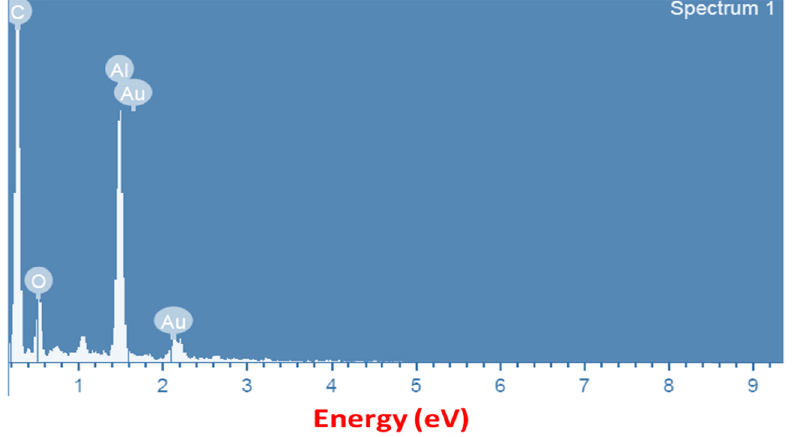
Figure 2: EDX spectrum of prepared AuNPs.